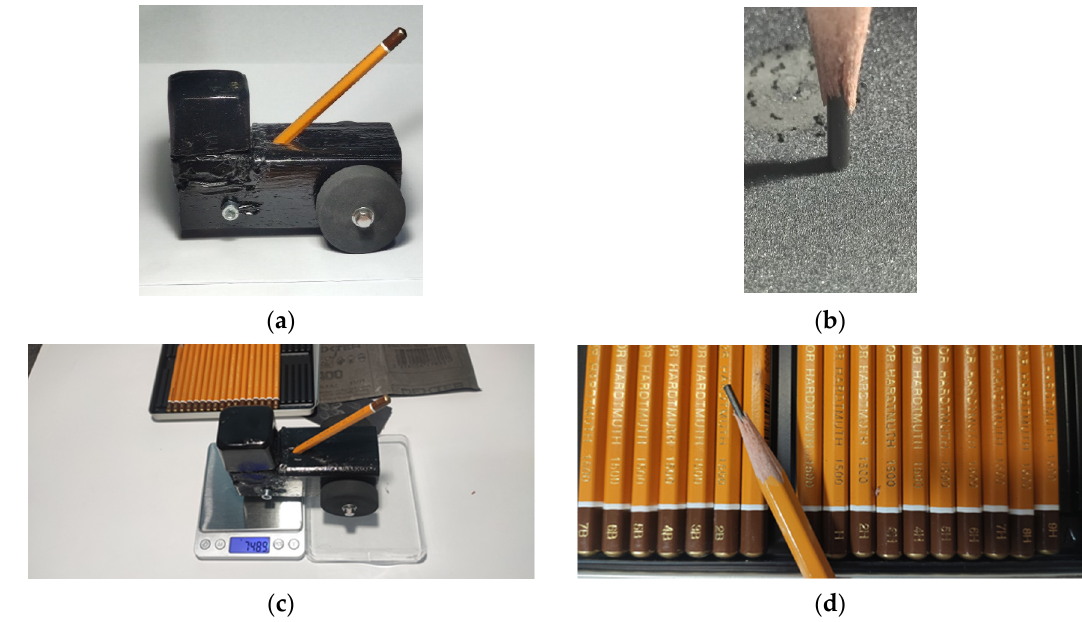
Figure 4. The set for testing the hardness of coatings using the pencil method; ( a ) tester with pencil, ( b ) pencil prepared for examination according to the standard, ( c ) device weight measurement and ( d ) view of pencils of different hardness used in the